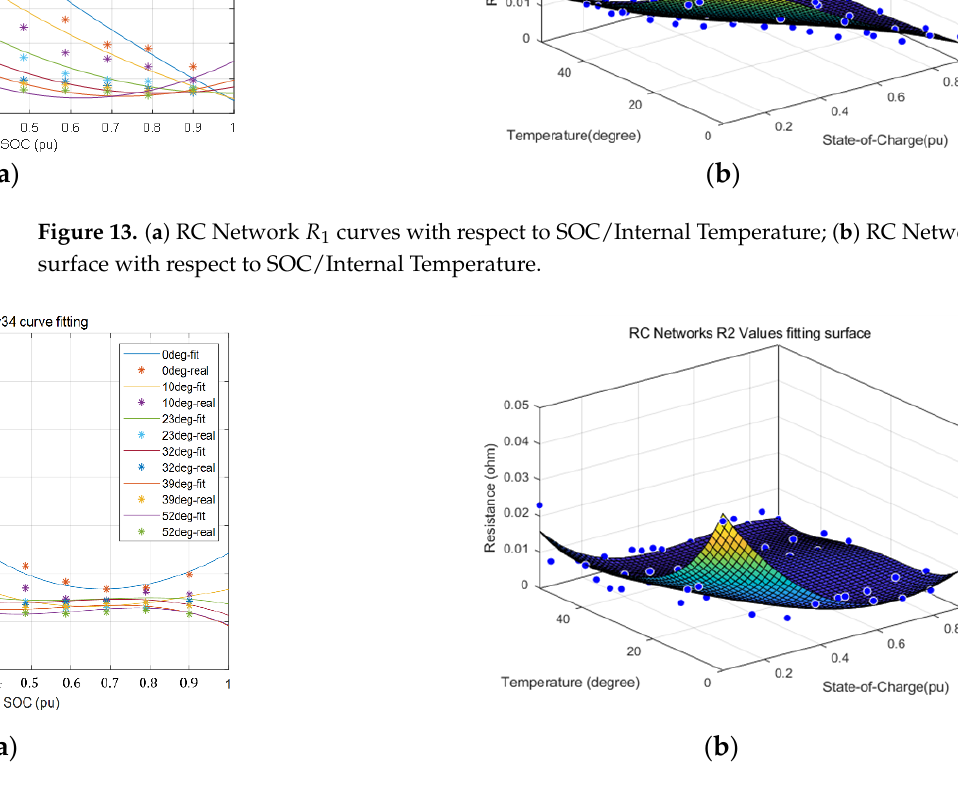
Figure 14. ( a ) RC Network R 2 curves with respect to SOC/Internal Temperature; ( b ) RC Network R 2 surface with respect to SOC/Internal Temperature. Table 7. Setting parameters for the Q-learning agent and training options.